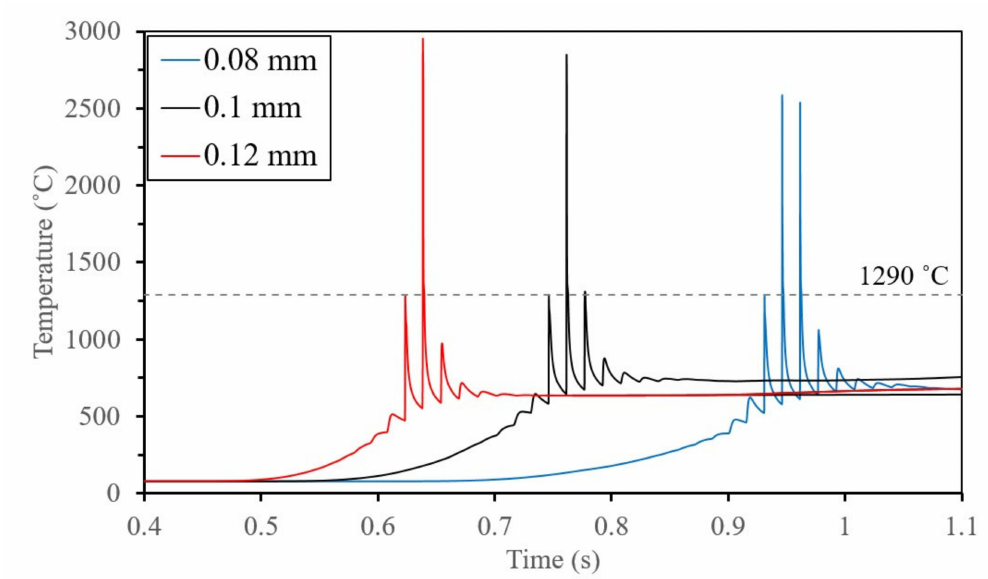
Figure 30. Temperature history for different hatch spacing at 220 W and 650 mm/s.